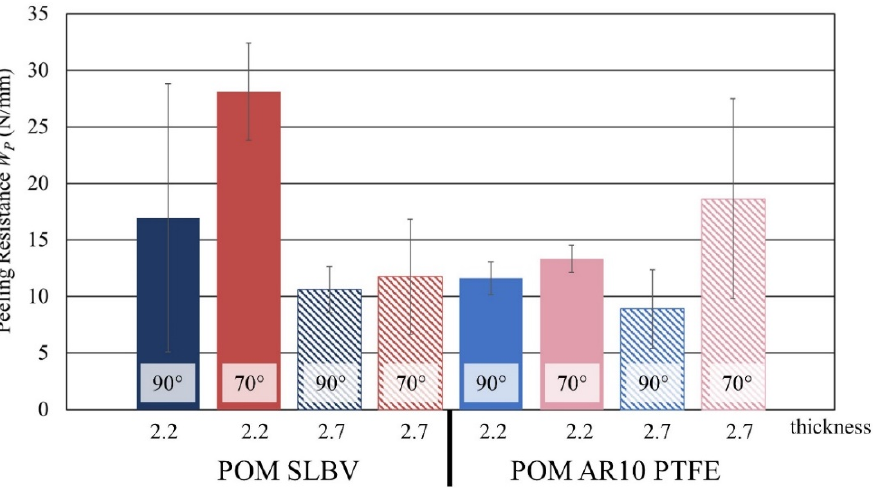
Figure 10. Peeling resistance W P of the processed samples.